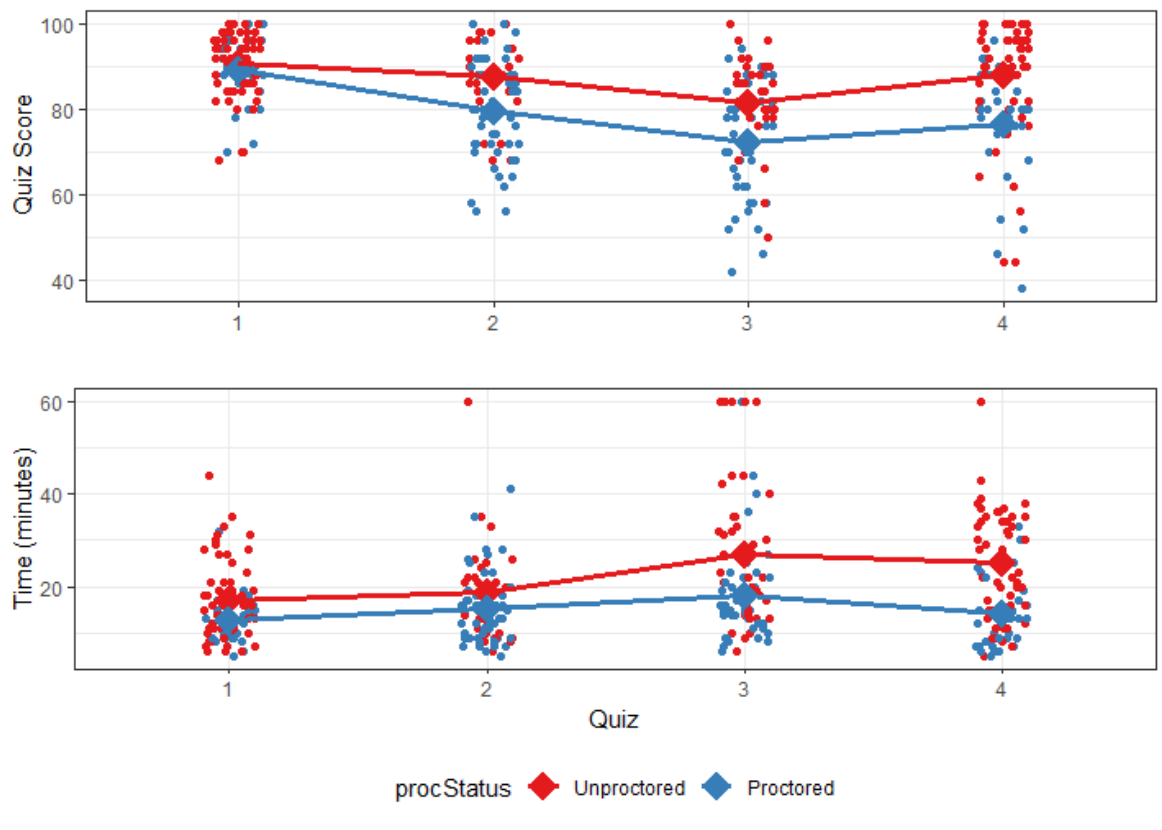
Figure 1 . Quiz scores (top) and quiz times (bottom) – when unproctored and